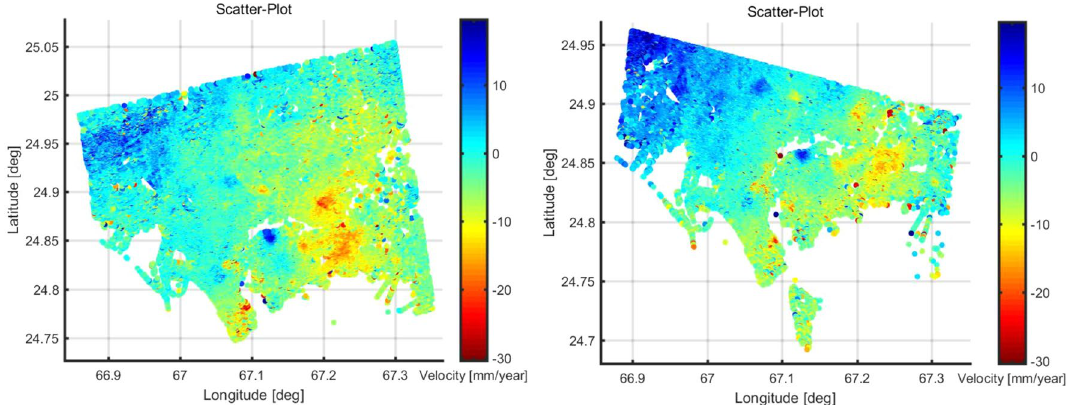
Figure 7. The scatter plots of Sentinel-1 data ascending and descending path on the lift to the right side